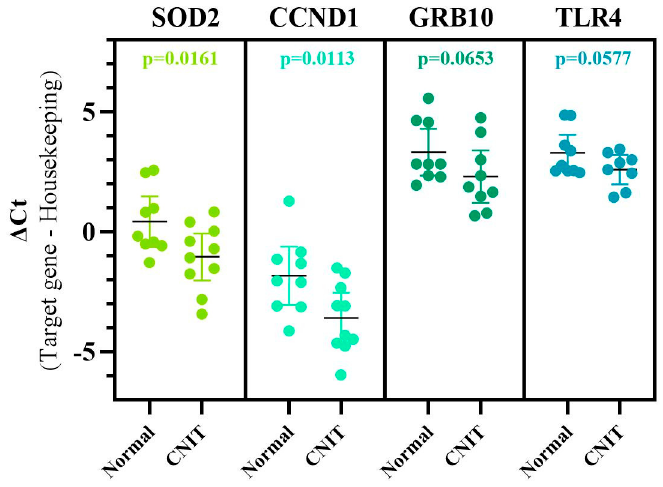
Figure 5. QPCR validation of four candidate genes using CNIT and Normal samples. Plotted with mean values and 95% confidence intervals. Gene expression normalized using the GAPDH housekeeping gene. A decrease in ∆ Ct represents an increase in gene expression. SOD2 and CCND1 were significantly upregulated, while GRB10 and TLR4 showed a trend in significance.